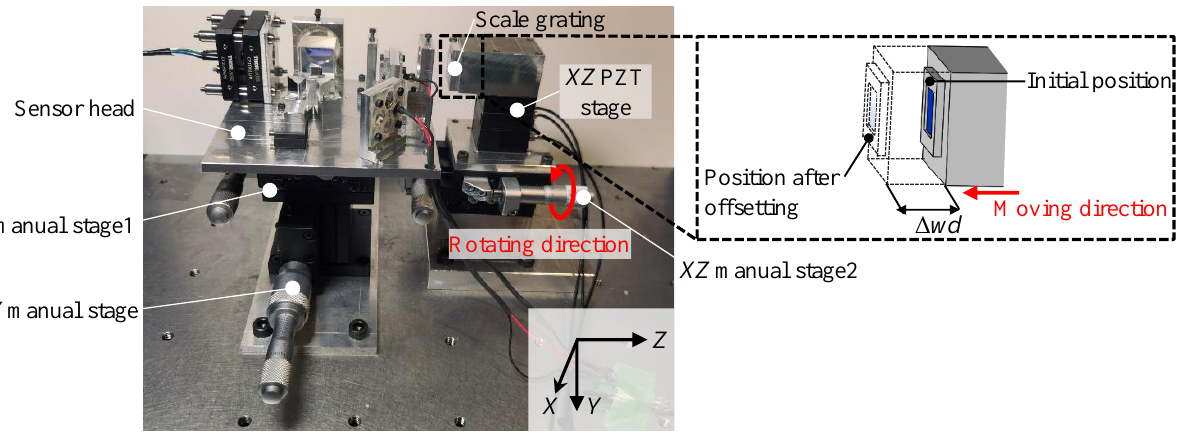
Figure 11. Schematic of the experimental setup when giving the offset to test the Z -directional measurement range of the surface encoder.